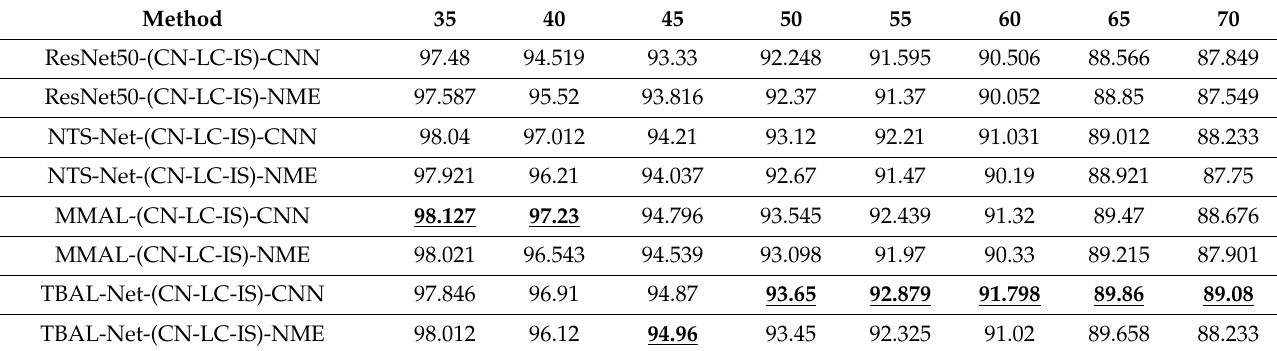
Evaluation on FGVC-Aircraft. Table 7 and Figure 5b show the experimental results on FGVC-Aircraft. We can observe similar results as CUB-200-2011. In the initial two phases, MMAL has demonstrated better performance, and TBAL-Net catches up since the third phase when the number of classes reaches 45. It is also observed that the performance differences among the compared models are relatively small. This may be caused by the lower number of classes of the FGVC-Aircraft dataset, which leads to more samples per class, allowing each model to learn more informative features. Table 7. Performance (Top-1 Accuracy %) on FGVC-Aircraft as the number of classes increases from 35 to 70. Method